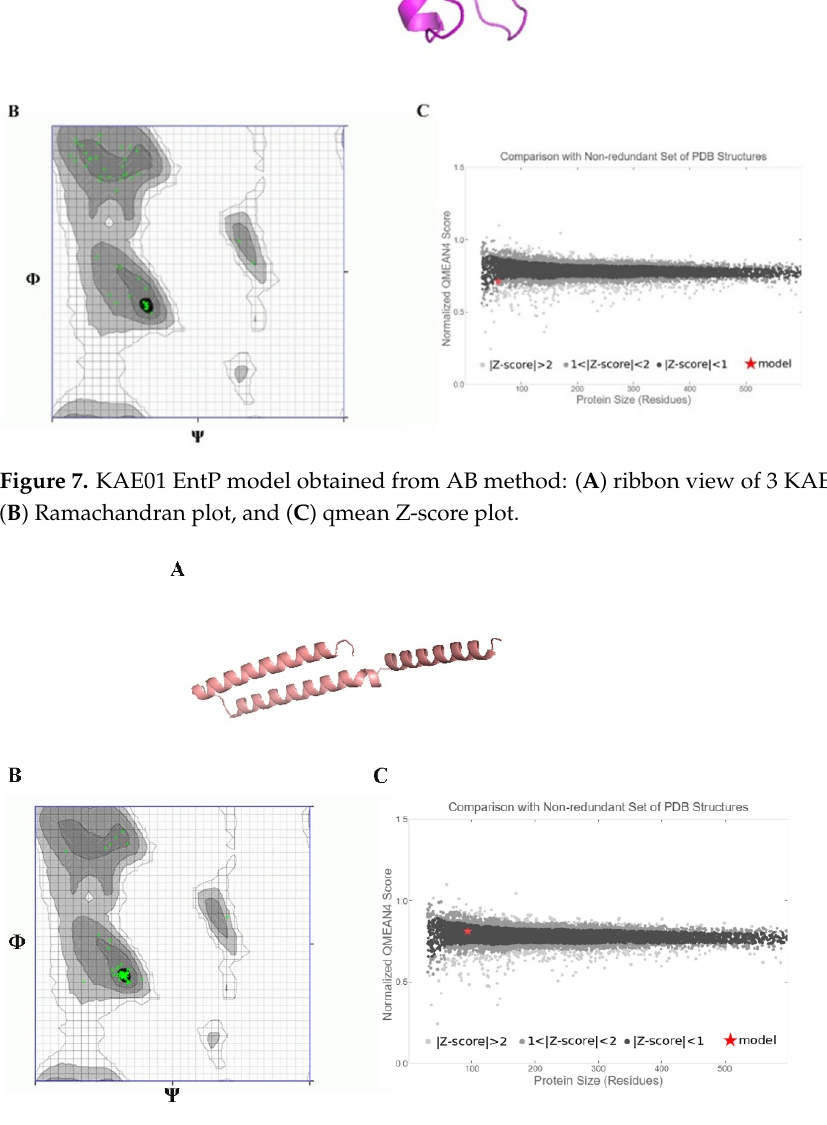
Figure 8. KAE01 EntA model: ( A ) ribbon view of 3 KAE01 EntA model, ( B ) Ramachandran plot, and ( C ) qmean Z-score plot.